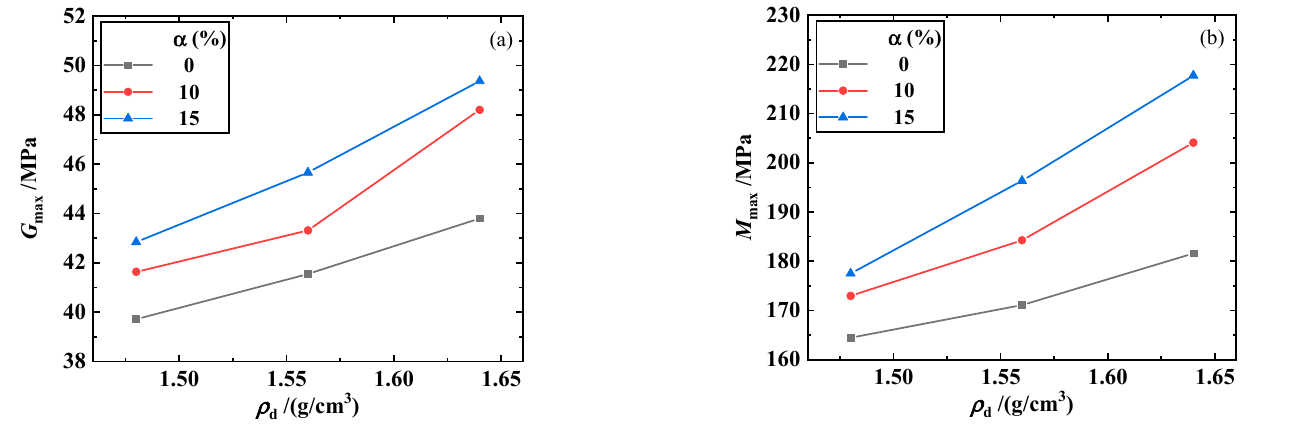
Figure 6. Relationship between G max , M max , and dry density, ρ d , of the biochar–clay mixture: ( a ) G max - ρ d ; ( b ) M max - ρ d .